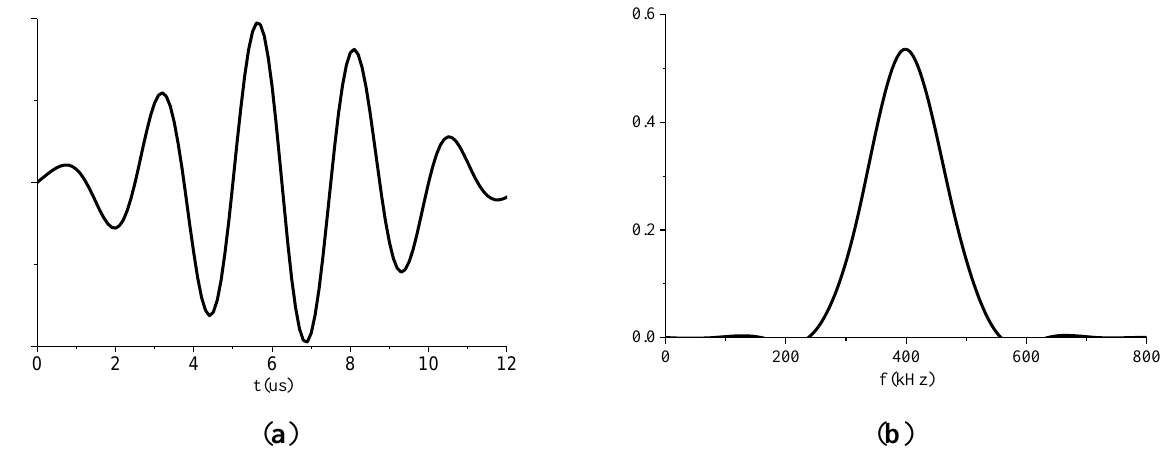
Figure 7. Elliptical shape of the modeled micro-crack.